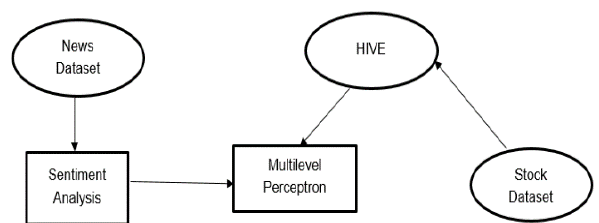
Figure 1 . Architecture of the proposed